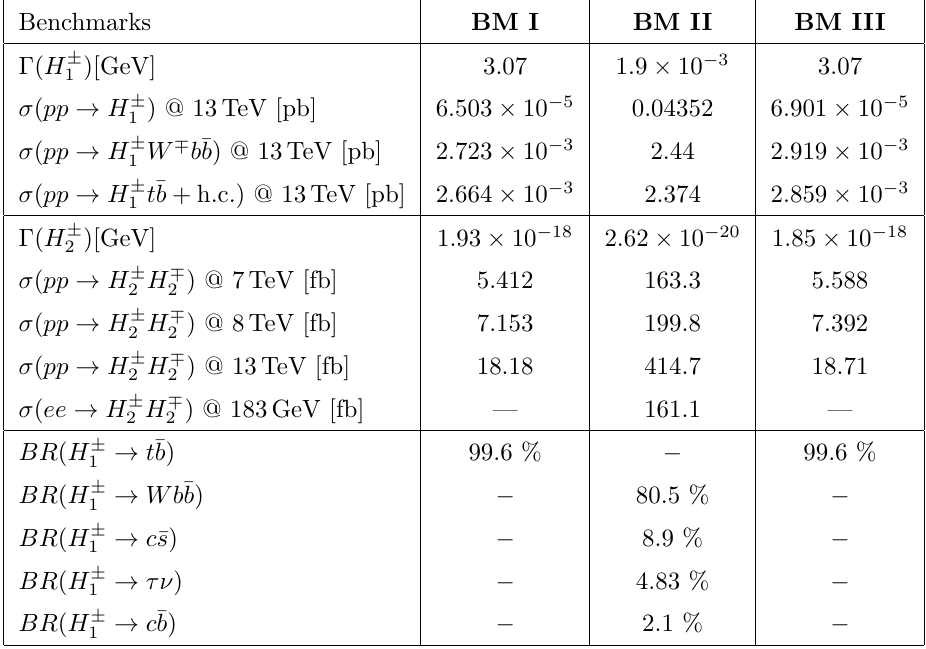
Table 4 . Properties of the light charged Higgs states for the BM I , BM II and BM III benchmark scenarios.